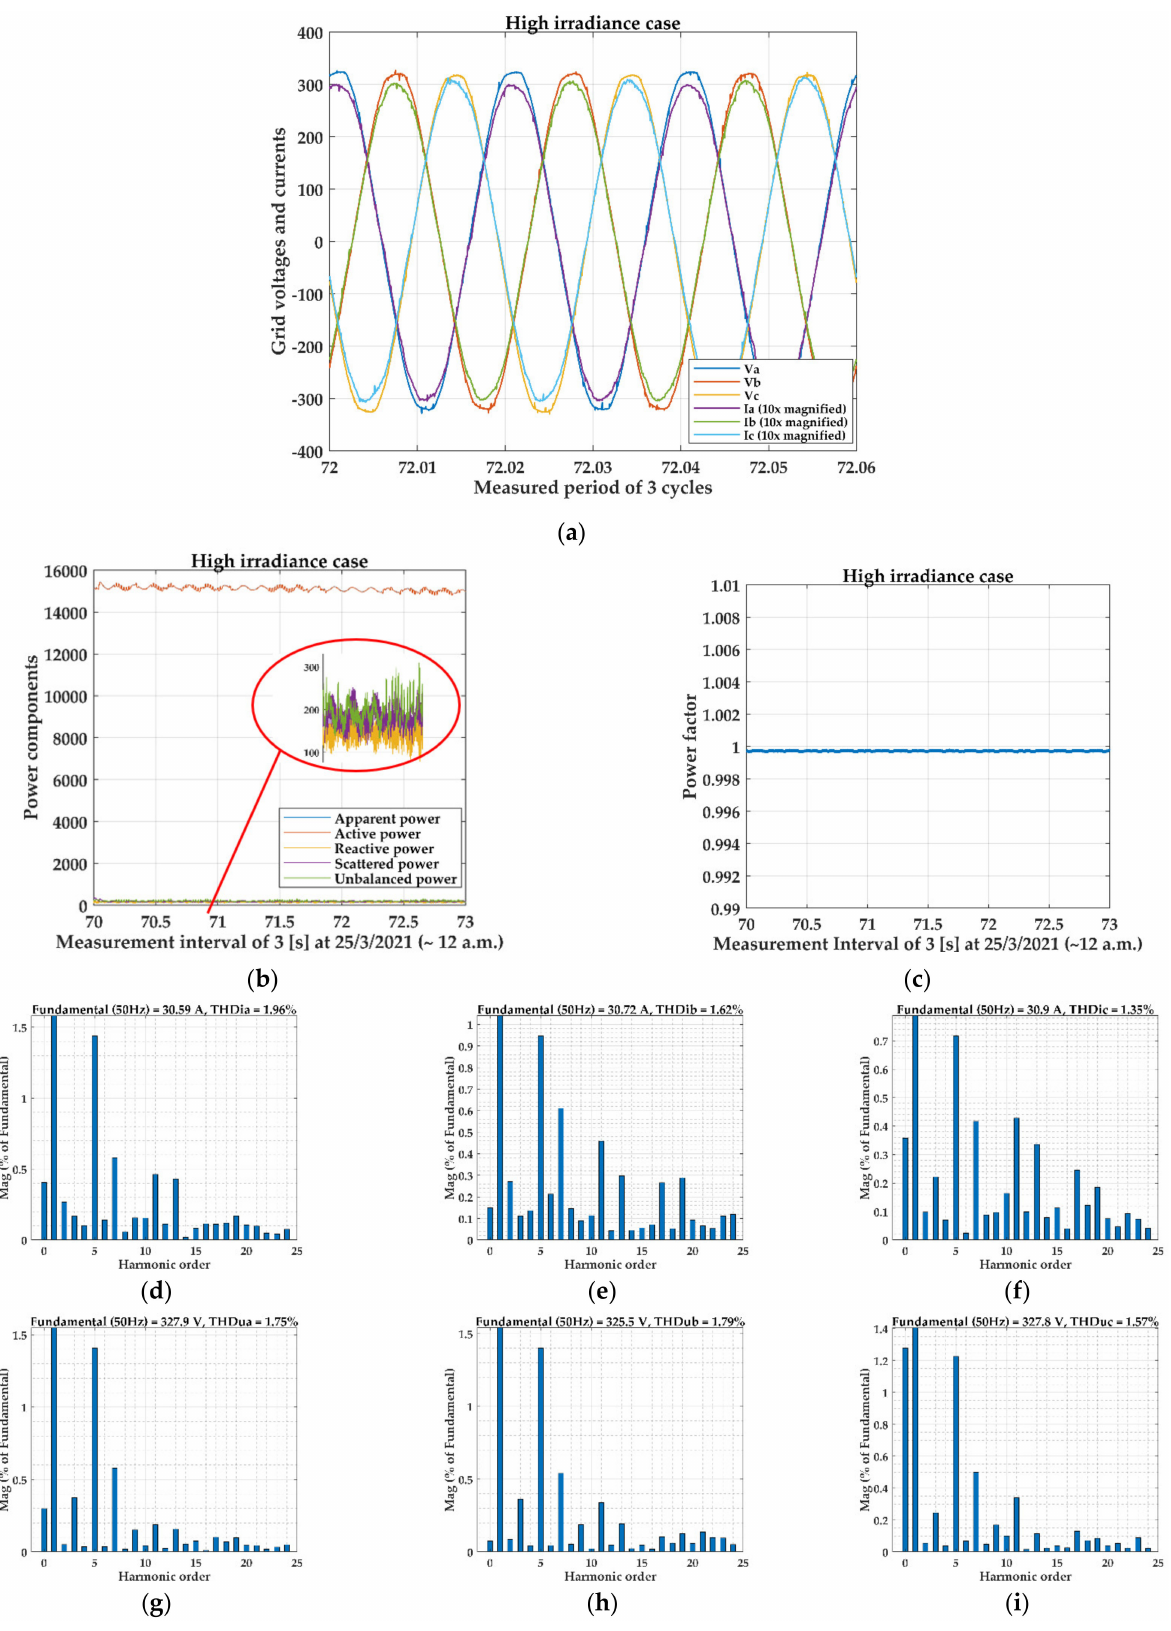
Figure 8. Experimental results for the high irradiance case: ( a ) Grid voltage and current waveforms; ( b ) power components according to CPC theory; ( c ) power factor; ( d – f ) harmonic spectra and THD I factors of inverter currents; ( g – i ) harmonic spectra and THD U factors of grid